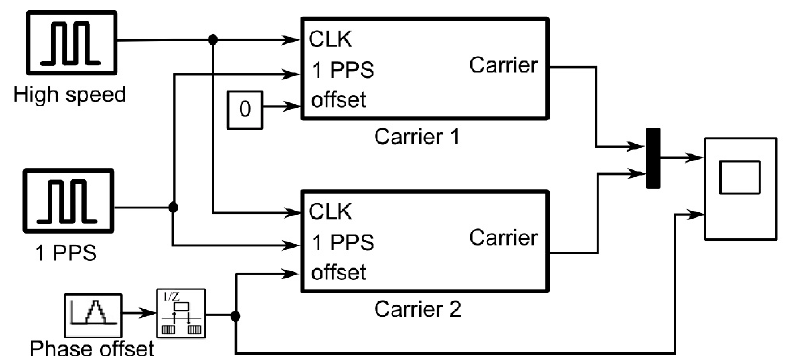
Figure 7. Phase adjustment simulation model block-diagram.